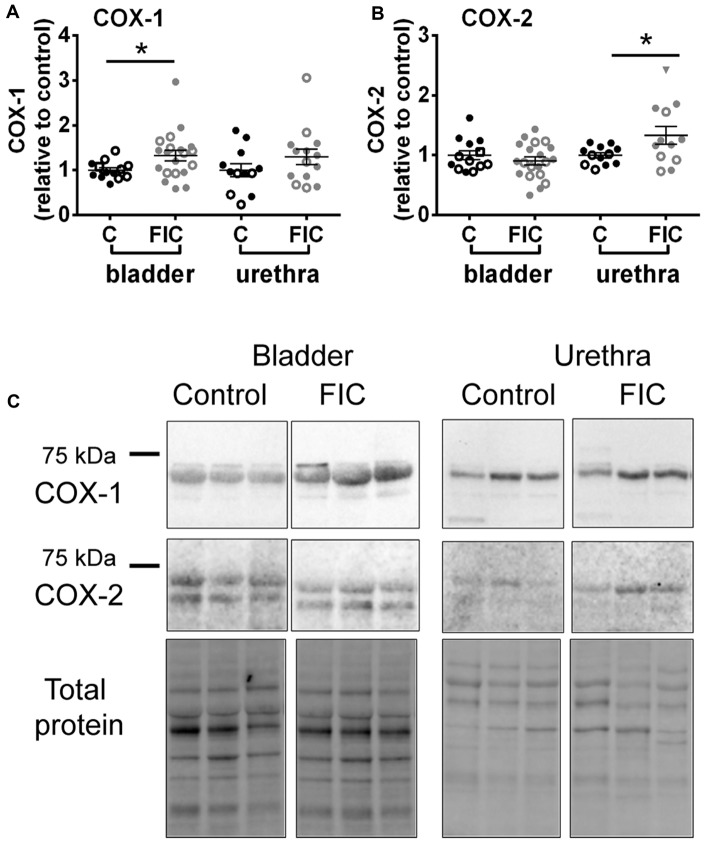
Cyclooxygenase (COX)-1 and COX-2 expression in the mucosa of the bladder and urethra. (A) COX-1 expression in the mucosa of the bladder (circles) and urethra (triangles) from control (n = 13 bladders and 12 urethral tissues) and FIC (n = 20 bladder and 14 urethral tissues) cats. Statistical significance was tested using Mann-Whitney test (bladder p = 0.03, urethra p = 0.31). (B) COX-2 expression in the mucosa of the bladder (circles) and urethra (triangles) from control (n = 13 bladders and 12 urethral tissues) and FIC (n = 20 bladder and 12 urethral tissues) cats. Statistical significance was tested using Mann-Whitney test (bladder p = 0.47, urethra p = 0.047). Data are presented as single points from individual cats with mean ± SEM. Asterisk (*) indicates p < 0.05. In all panels, each symbol represents data from one animal. Open circles represent males, closed circles females and open squares represent undocumented sex. (C) Representative blots from bladder and urethra indicating the expression of COX-1 and COX-2. Each of the three lines (control and FIC) represents tissue from a single cat probed for COX-1 (upper panel) COX-2 middle panel, and total protein (lower panel) which was used for normalization. The expected band sizes for COX-1 and COX-2 are 75 kDa.